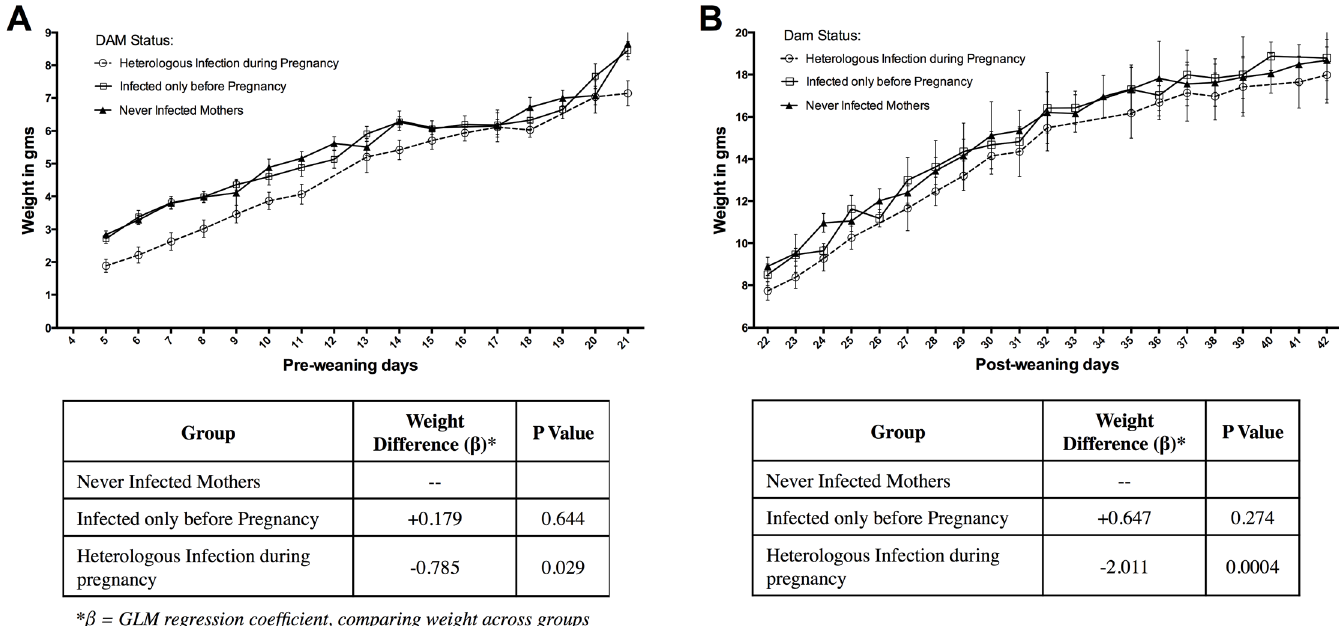
Fig 6. Weight gain in pups born to dams that received Pcc- AS before and Pcc- CB during pregnancy, dams that received Pcc- AS before pregnancy and no other infection during pregnancy, or dams that were never infected. Weights of pups were documented for up to 42 days after birth. (A) Weight in grams throughout the pre-weaning period. (B) Weight in grams throughout the post-weaning period. Data are presented as means with 95% confidence intervals. Differences in weight were analyzed by creating a generalized linear model while taking into account the correlation due to repeated measures within pups and due to multiple pups born to the same dam. β = GLM regression coefficient comparing weight across